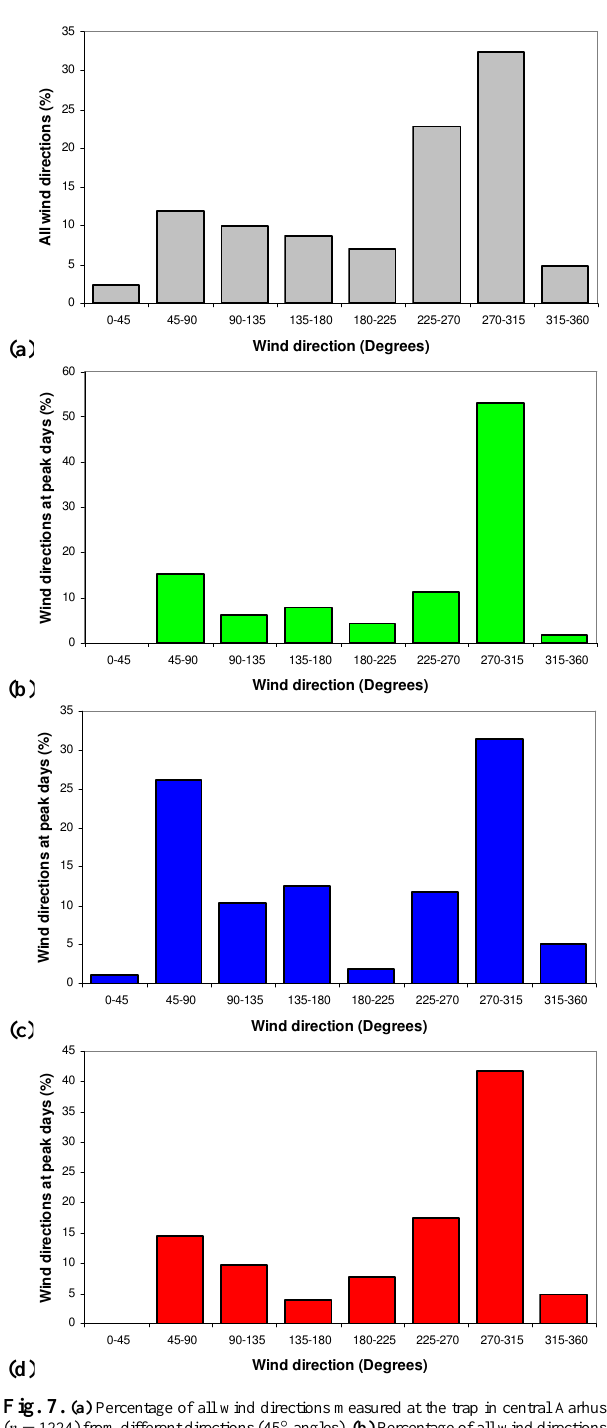
Fig. 7. (a) Percentage of all wind directions measured at the trap in central Aarhus ( n = 1224 ) from different directions (45 ◦ angles). (b) Percentage of all wind directions measured at the trap in central Aarhus ( n = 255 ) from different directions (45 ◦ angles) that were measured at peak days at TV2-Øst. (c) Percentage of all wind directions measured at the trap in central Aarhus ( n = 256 ) from different directions (45 ◦ angles) that were measured at peak days at Rundhøjskolen. (d) Percentage of all wind direc- tions measured at the trap in central Aarhus ( n = 103 ) from different directions (45 ◦ angles) that were measured at peak days at the station in Central Aarhus. Peak days are those when the daily average Poaceae pollen counts exceed 50grainsm − 3 . Note that the scales on the y-axis are not identical in all four